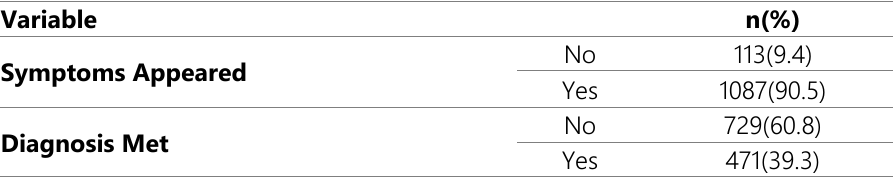
Table 4: Association of Food addiction with psychological health problems. Food